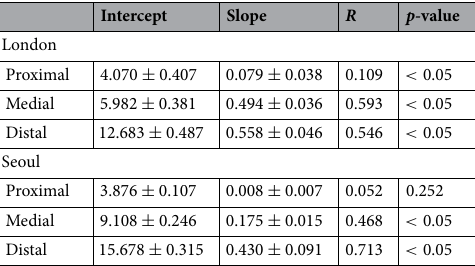
Table 3. Results of linear regressions considering d 1 i as the explanatory variable and ˆ µ 3-component Poisson mixture model as the response variables. Piccadilly Circus is considered to be the nucleus in London and City Hall in